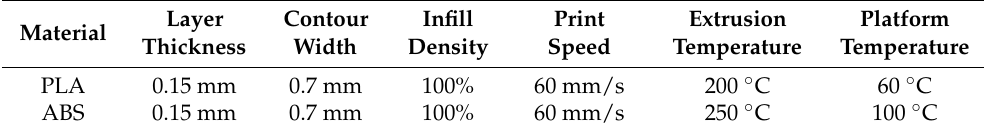
Table 1. Process parameters for FDM